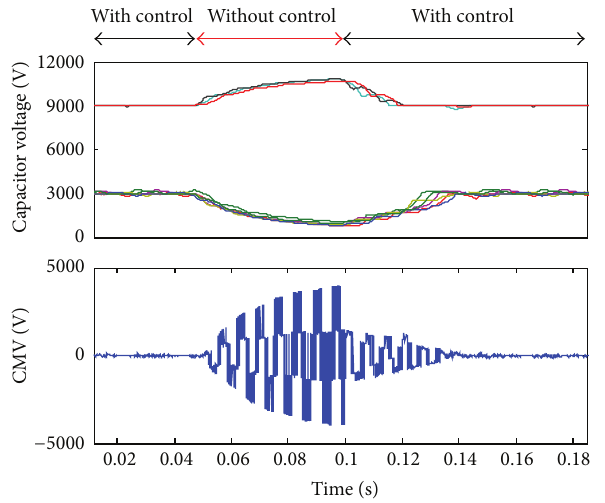
Figure 8: Simulation results with and without proposed